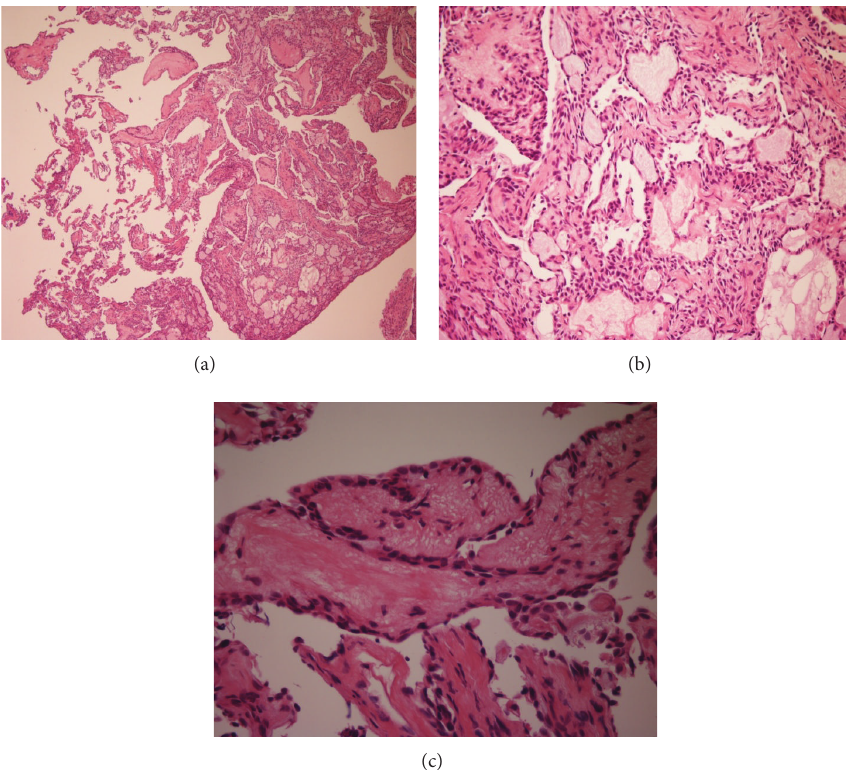
Figure 4: Histopathologic study of ELST. The histologic sections showed the papillary and glandular-cystic architecture of the ELST (a) (H&E, 50x). There were cystic glandular spaces filled with colloid-like material which was remarkably similar to thyroid tissue (H&E, 200x) (b). The papillary structures were lined by a single layer of low cuboidal epithelial cells. There were minimal cellular pleomorphism and rare mitotic activity (H&E, 200x) (c).